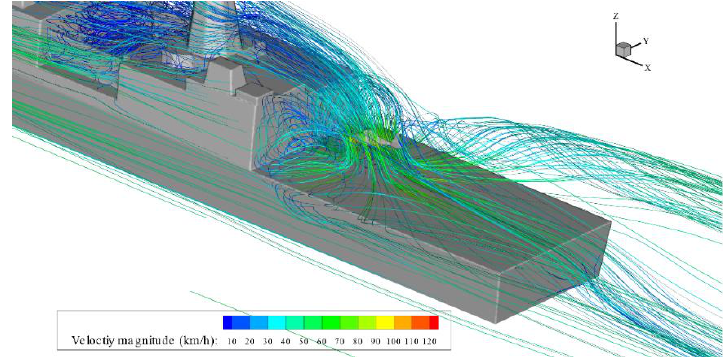
Figure 10. Streamtrace map under 0° and 55 km/h WOD condition.